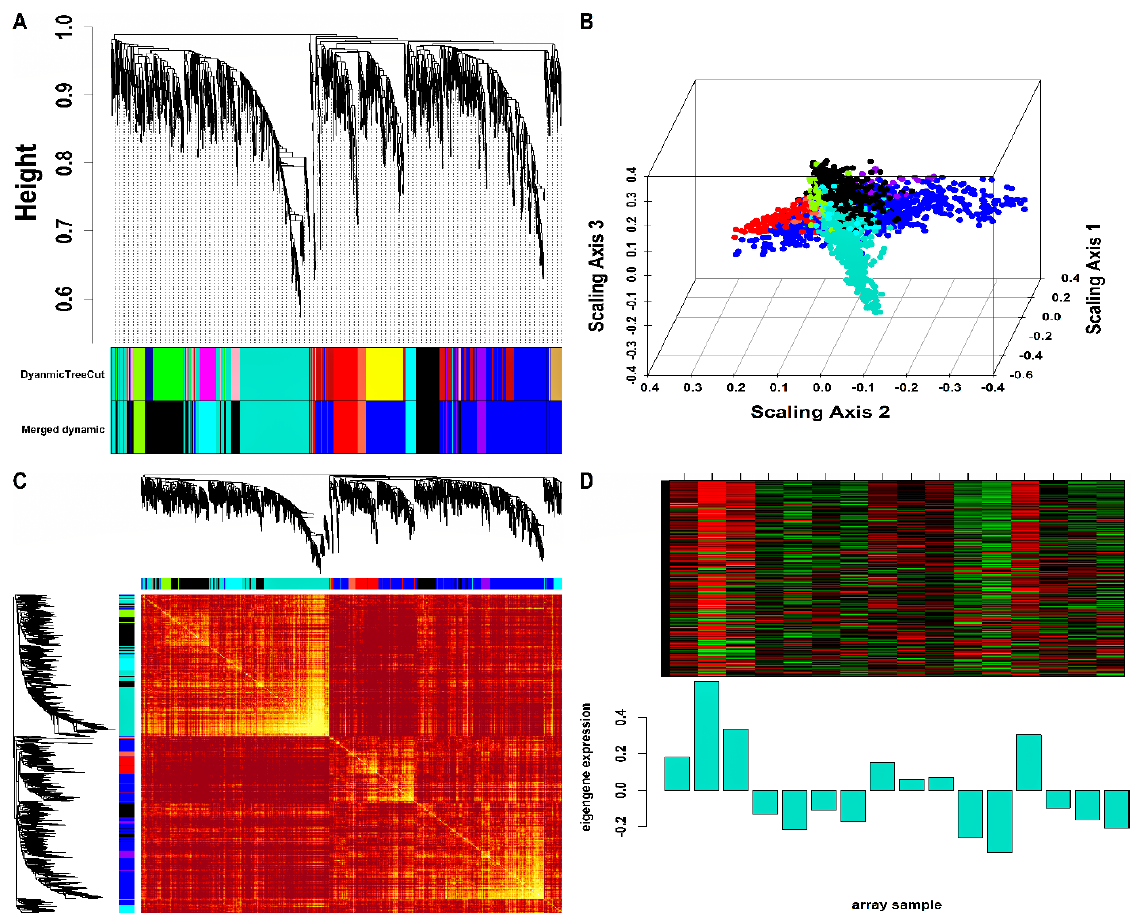
Figure 2. ( A ) Hierarchical clustering dendrogram of 2016 WB-DEGs clustered based on dissTOM together with original (16) and merged (9) module colors. The sizes of the original modules were as follows: black (108), blue (300), brown (207), cyan (42), green (151), green-yellow (63), grey (6), magenta (85), midnight-blue (39), pink (94), purple (65), red (126), salmon (43), tan (51), turquoise (455), yellow (181). In addition, the sizes of merged modules were as follows: black (392), blue (739), cyan (127), green-yellow (63), grey (6), purple (65), red (126), salmon (43), turquoise (455). ( B ) 3D MDS plot where each colored point denotes a gene belonging to the module of its equivalent color in the case of the WB group. ( C ) Representation of WGCN as a TOM plot for WB-DEGs. Genes within columns and their corresponding rows were hierarchically clustered by cluster dendrograms (displayed along the top and left side of the plot). Progressively darker and lighter red colors within the matrix indicate higher and lower topological overlap among genes. Dark-colored blocks along the diagonal signify the modules. ( D ) Expression heatmap of turquoise module genes where the rows and columns correspond to genes and samples. The red and green color bands within the heatmap imply higher and lower expression levels across turquoise module genes. In addition, the corresponding ME expression levels (along the y -axis) across all samples (along the x -axis) are displayed at the bottom panel of the module heatmap in the form of a barplot. WGCN, Weighted Gene Co-expression Network; TOM, Topological Overlap Matrix.